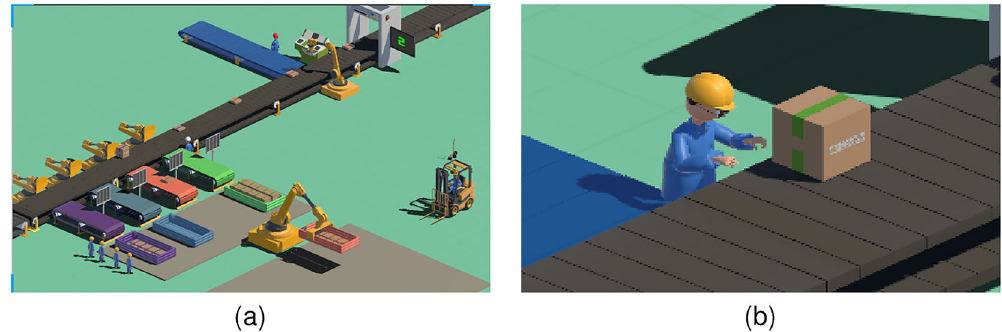
Figure 2. Our prototype system is in which participants experience a tedious task with a virtual partner (i.e., an agent) in an IVE. ( a ) A user is playing with the prototype system. ( b ) A virtual agent is designed as a partner. See accompanying demo Video for more details.